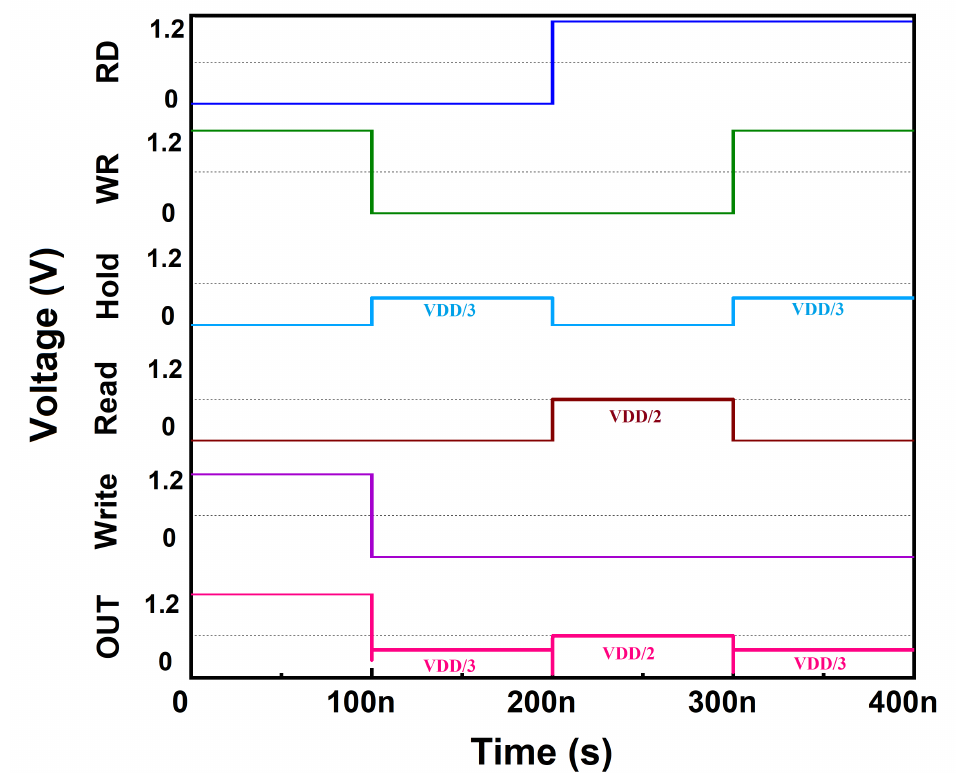
Figure 5. Transient response of decision circuit at different